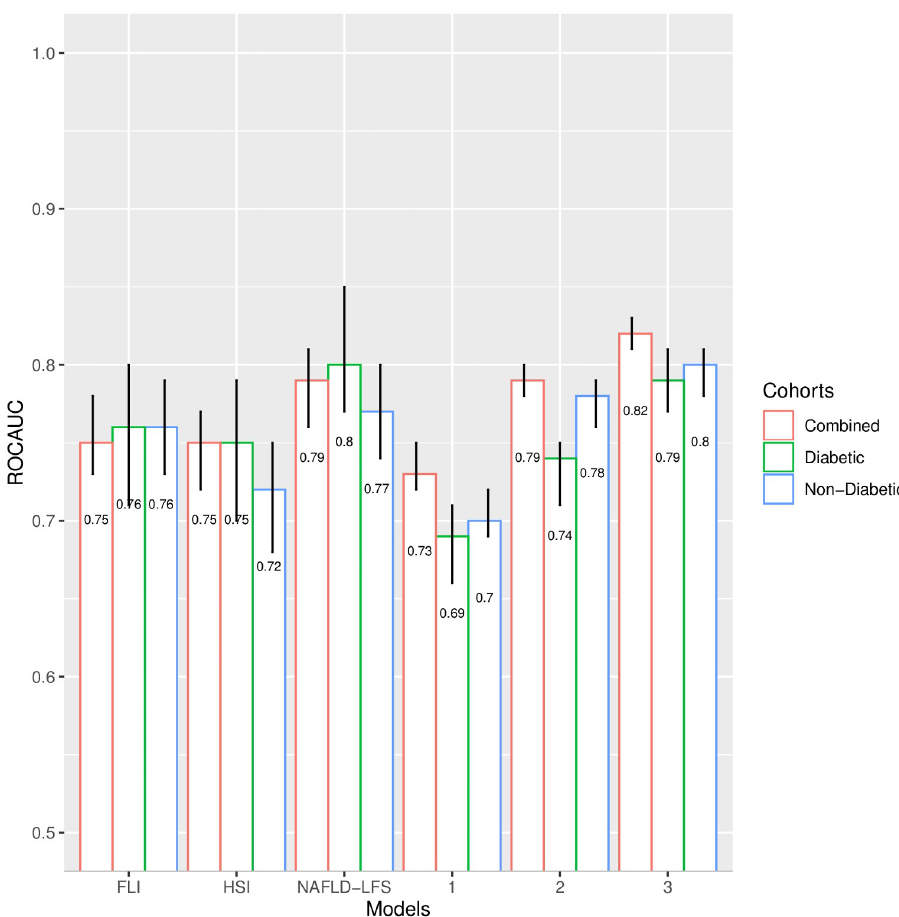
Fig 3. Receiver operating characteristic area under the curve (ROCAUC) with 95% confidence interval (error bars) for clinical models 1–3, fatty liver index (FLI), hepatic steatosis index (HSI), and non-alcoholic fatty liver disease liver fat score (NAFLD-LFS) in the IMI DIRECT cohorts. Model 1 includes 6 non-serological input variables: waist circumference, body mass index(BMI), mean systolic blood pressure, mean diastolic blood pressure, alcohol consumption, and diabetes status. Model 2 includes 8 input variables: waist circumference, BMI, fasting triglycerides (TG), alanine transaminase (ALT), aspartate transaminase (AST), fasting glucose (or hemoglobin A1C if fasting glucose is not available), alcohol consumption, and diabetes status. Model 3 includes 9 variables: waist circumference, BMI, TG, ALT, AST, fasting glucose, fasting insulin, alcohol consumption, and diabetes status. The FLI uses TG, waist circumference, BMI, and gamma-glutamyl transpeptidase. NAFLD-FLS was calculated using fasting insulin, AST, ALT, type 2 diabetes (T2D), and metabolic syndrome defined according to the International Diabetes Federation. The HSI uses BMI, sex, T2D diagnosis (yes/no), and the ratio of ALT to AST.